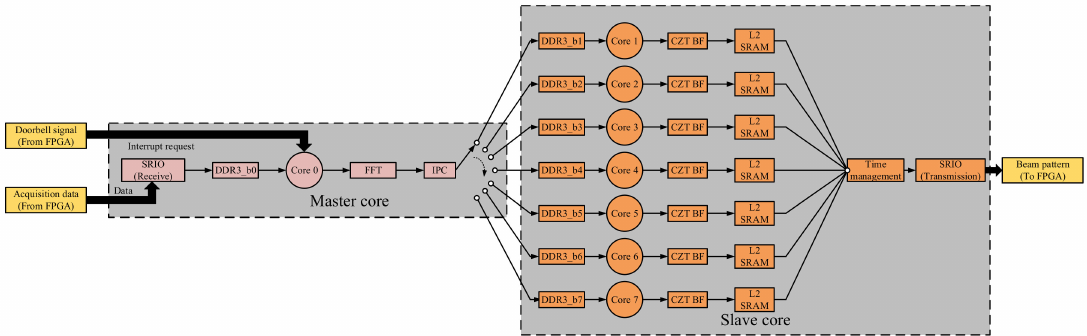
Figure 18. The architecture of multicore signal processing.